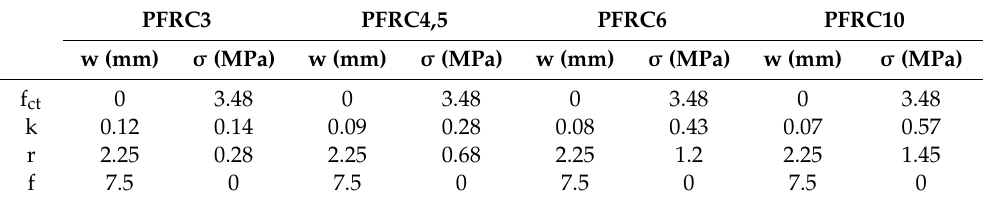
Table 3. Parameters of the polyolefin fibre-reinforced concrete (PFRC) softening functions.